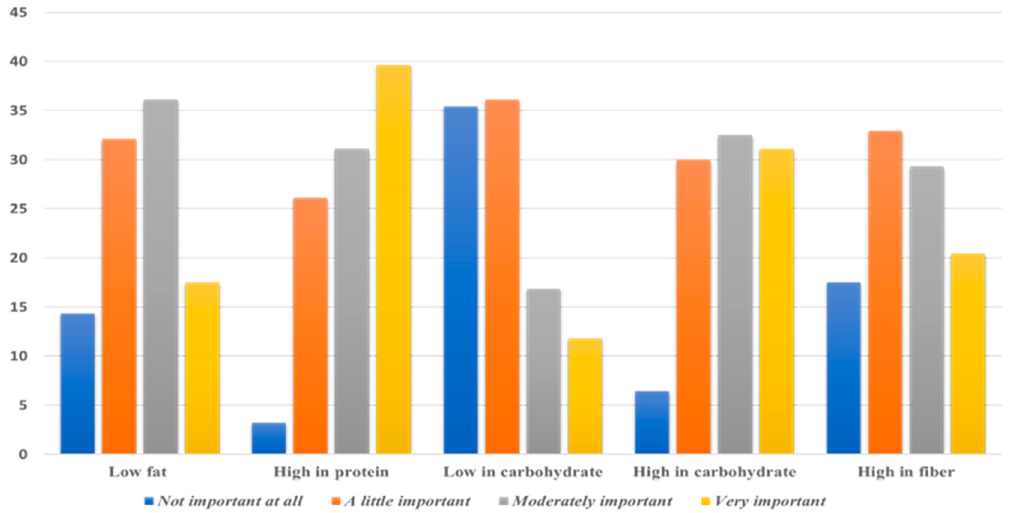
Figure 2. Preferred food type selection as before a workout (in